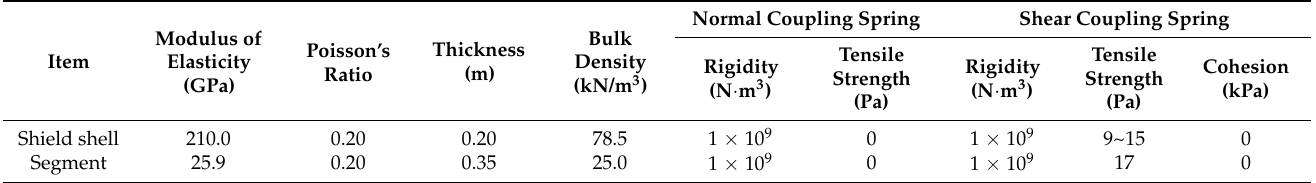
Table 3. Calculation parameters of structural elements.